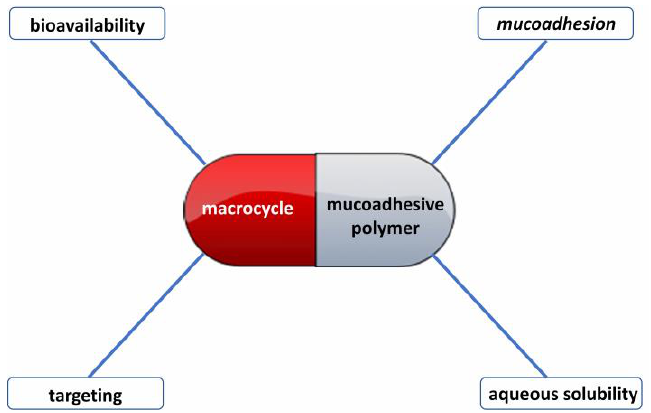
Figure 15. Graphic outline of the mixed macrocycle–polymer systems as mucoadhesive formulations.